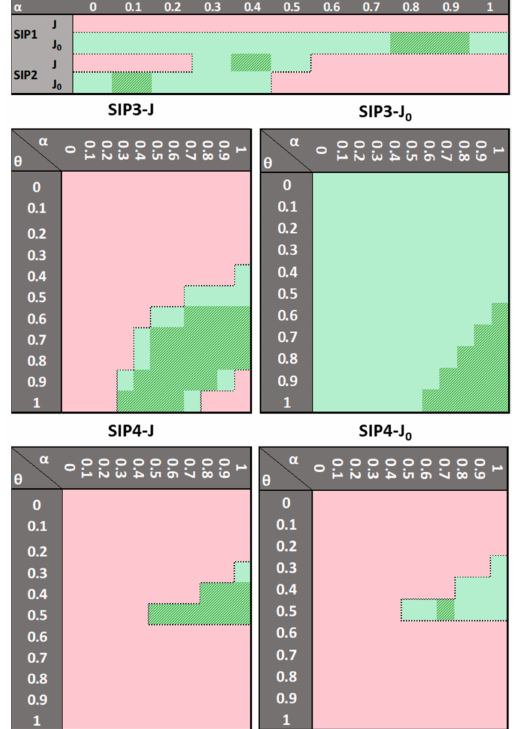
Figure 7. Convergence (green) and failure areas (red) in the s-parameter space for solving the case3012wp. Bold green areas indicate where the studied technique successfully converged, employ- ing the least number of iterations.